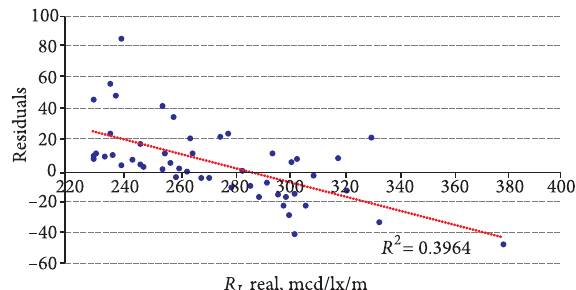
Fig. 4. Residual plot of difference between real and daytime visibility obtained from a